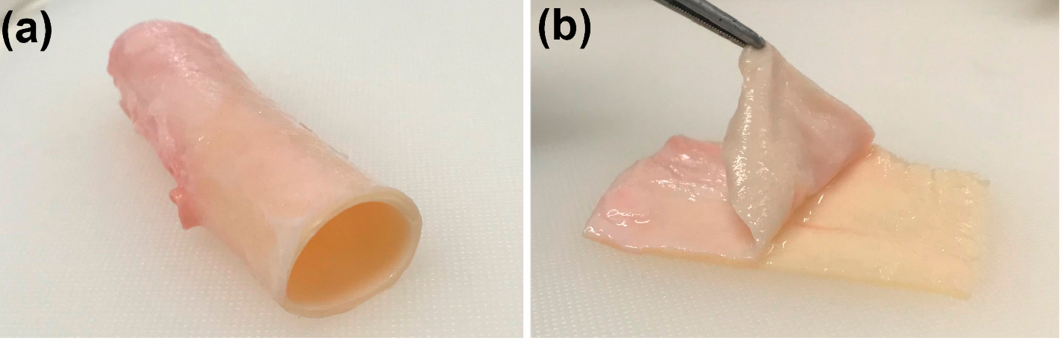
Figure 1. ( a ) A debrided segment of porcine abdominal aorta; ( b ) Stripping tunica adventitia off the outer side of tunica media.